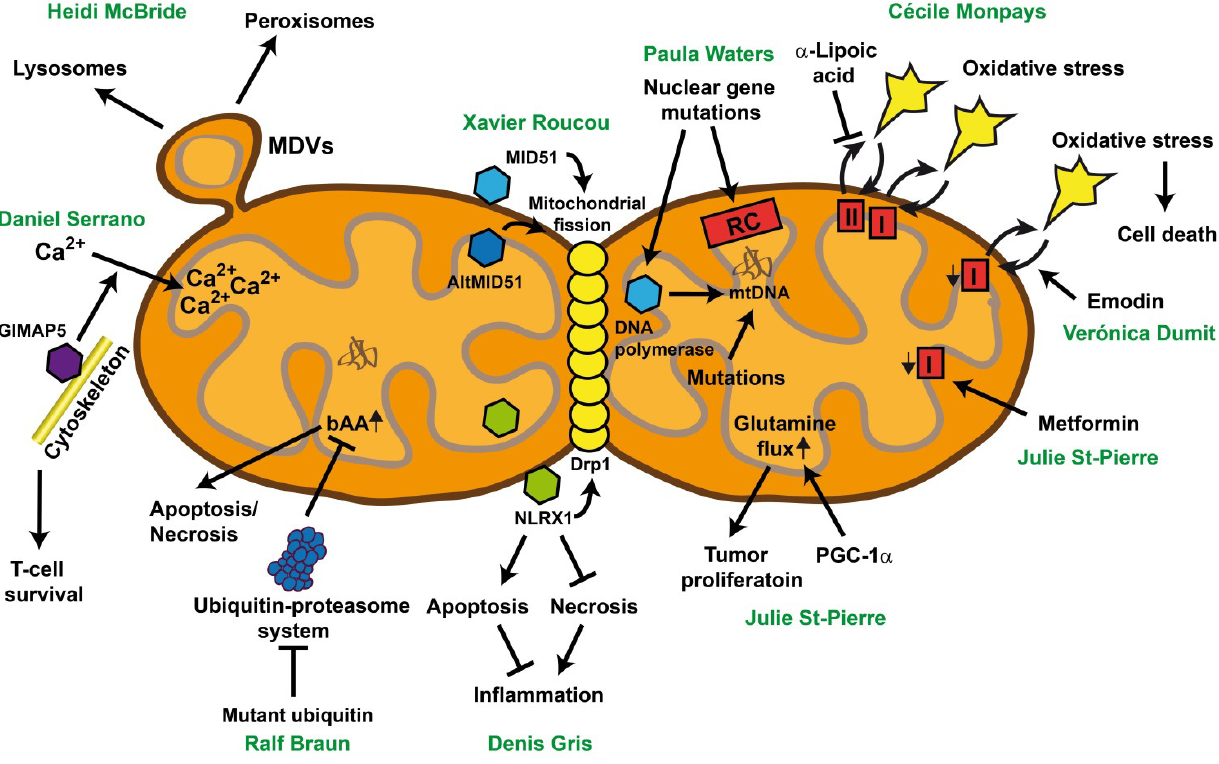
FIGURE 1: One mitochondrion, various disease-relevant pathways. For details see text. bAA: basic amino acids, MDV: mitochondrial-derived